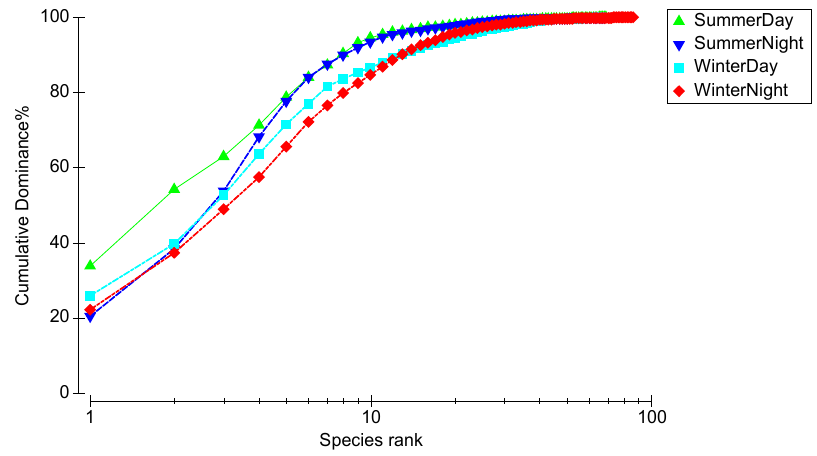
Figure 2. k-Dominance curves for samples of seagrass-associated decapod crustaceans from the Puerto Morelos reef lagoon. Each curve is based on average abundances at five replicate sites. Samples from each site were obtained in 10 trawls conducted with an epibenthic sled in the day and in 10 the night, in the summer of 1995 and the winter of 1998.